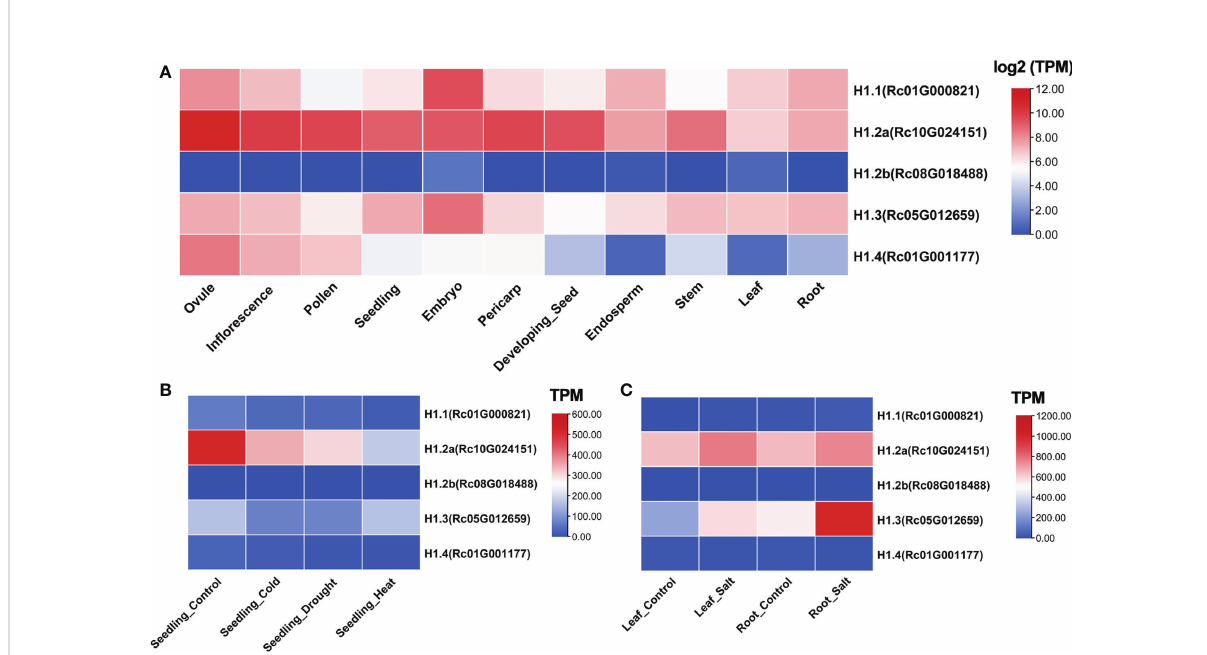
FIGURE 3 Expression pro fi les of H1 genes in castor bean. (A) Expression pro fi le across different tissues. Expression is based on the log2(TPM) values. (B, C) Expression pro fi le in different stresses. Expression is based on the TPM